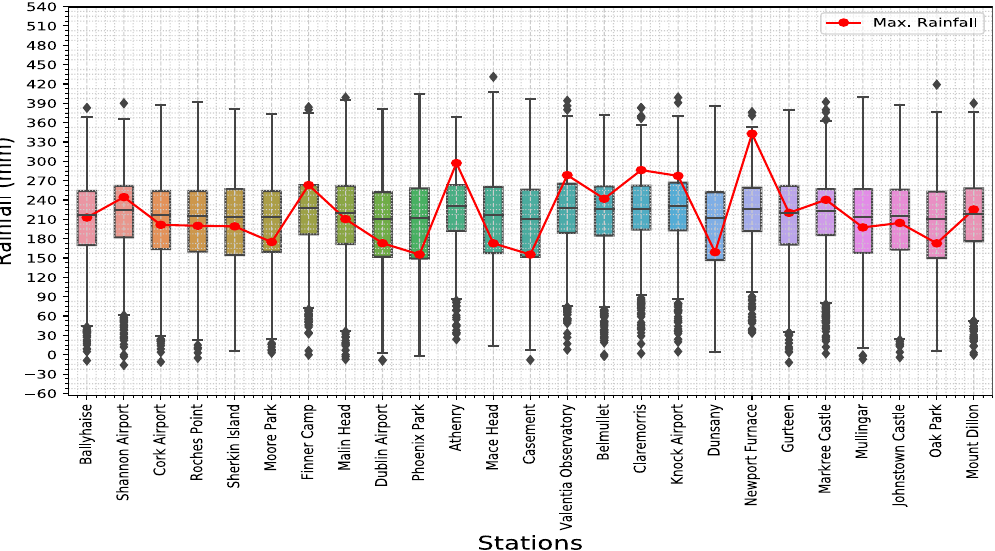
Figure 5: The maximum monthly rainfall amounts ( measured in millimeter ( mm )) for each station vs the predicted values represented by 95% prediction intervals for return period 100